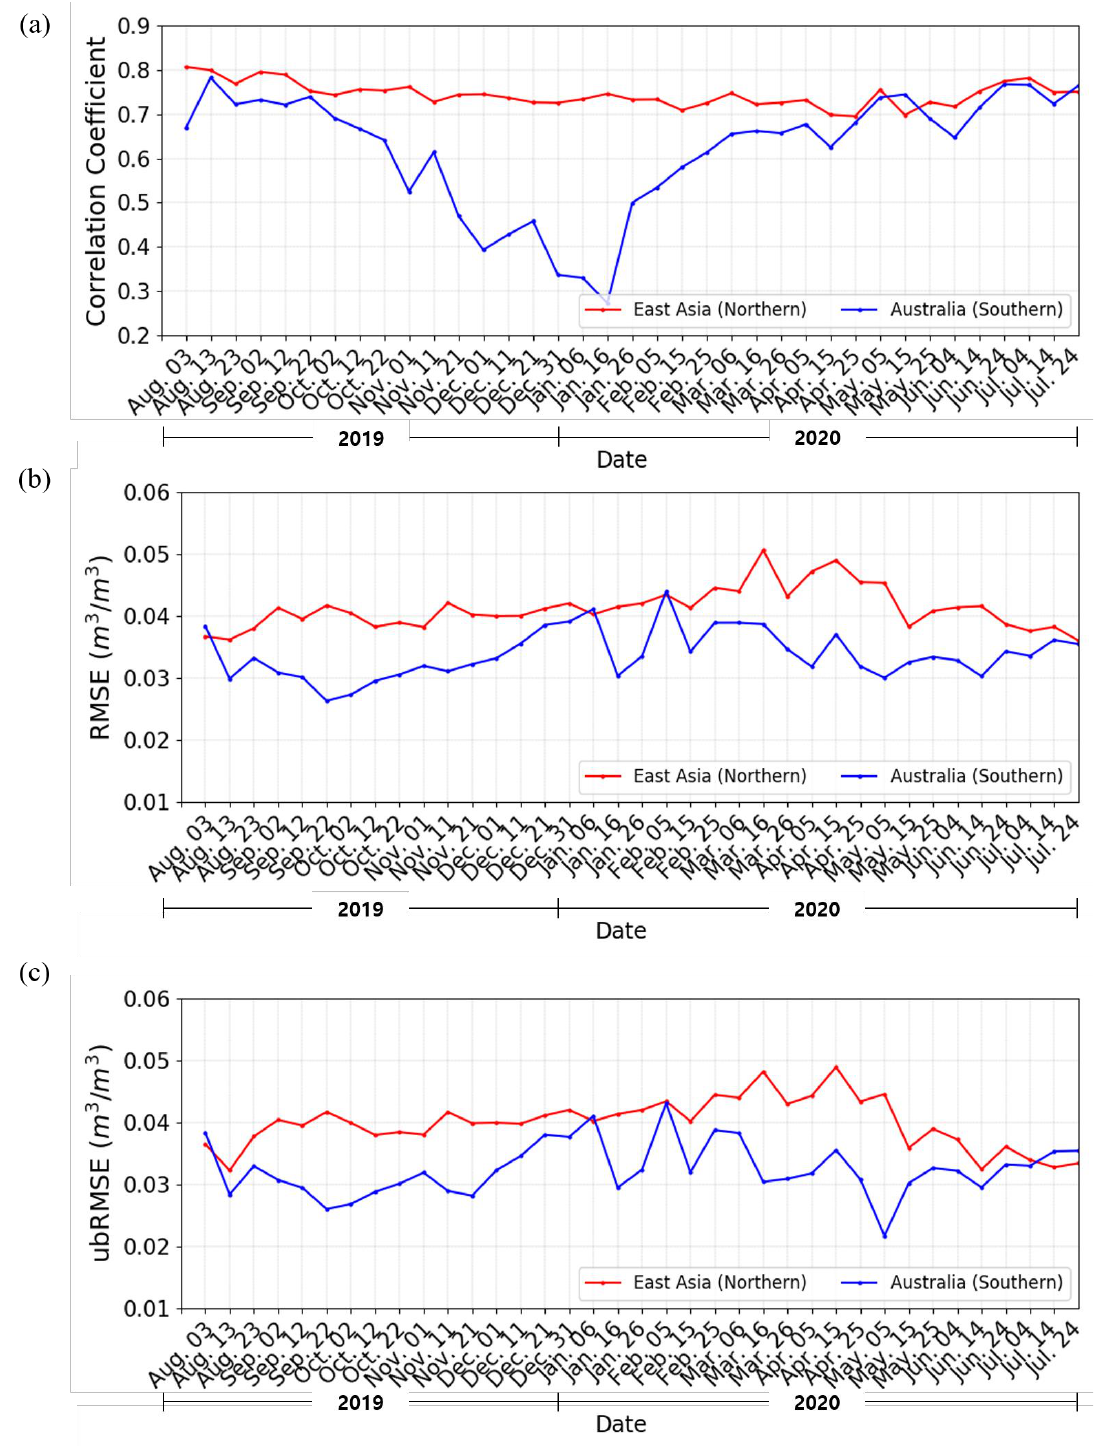
Figure 12. Temporal dynamics of the spatial ( a ) CC, ( b ) RMSE, and ( c ) ubRMSE between the 10-day-averaged GLDAS and GK-2A SM in East Asia and Australia from August 2019 to July 2020.